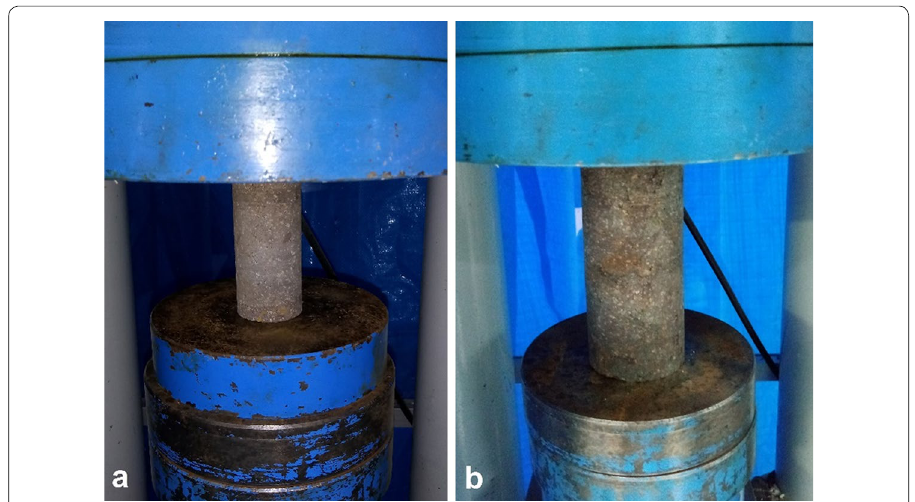
Fig. 5 Testing strengths of rock specimes with different diameters of 32 mm ( a ), 54 mm ( b )